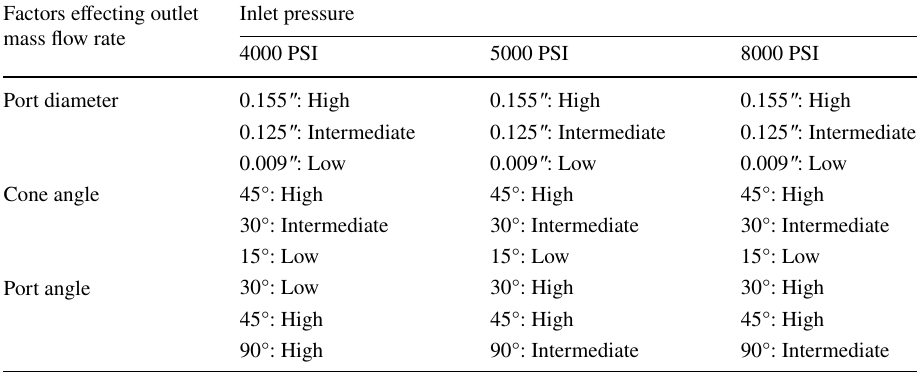
Table 7 Effects of port diameter, cone angle and port angle on outlet mass flow